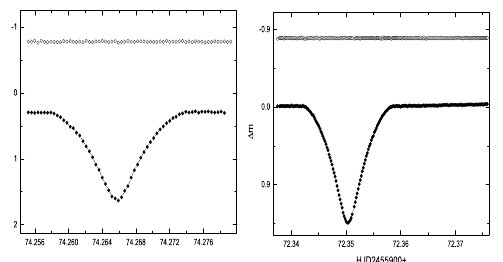
Figure 3: Light curves of NSVS07826147. Left panel: Eclipsing profiles of NSVS07826147 obtained with 85- cm telescope on May 26, 2012 in R band. Right panel: Obtained with 2.4-m telescope on Feb. 14, 2012 without filters. Dots refer to the magnitude differences between the target and the comparison star, and open circles to the magnitude differences between the comparison and check